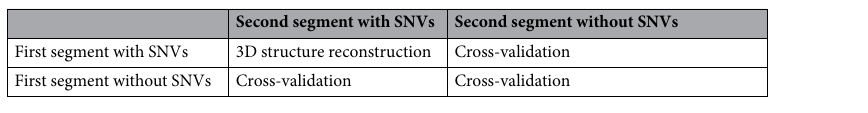
Table 2. How we treat the single diploid Hi-C